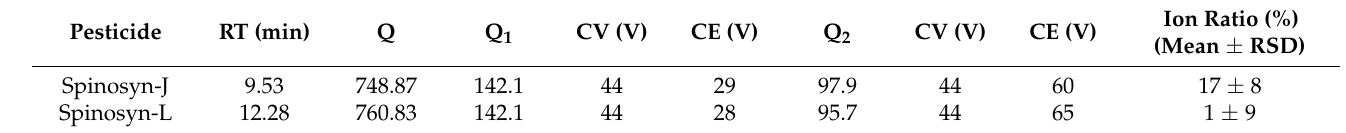
Table 1. Overview of LC–MS/MS monitoring of the